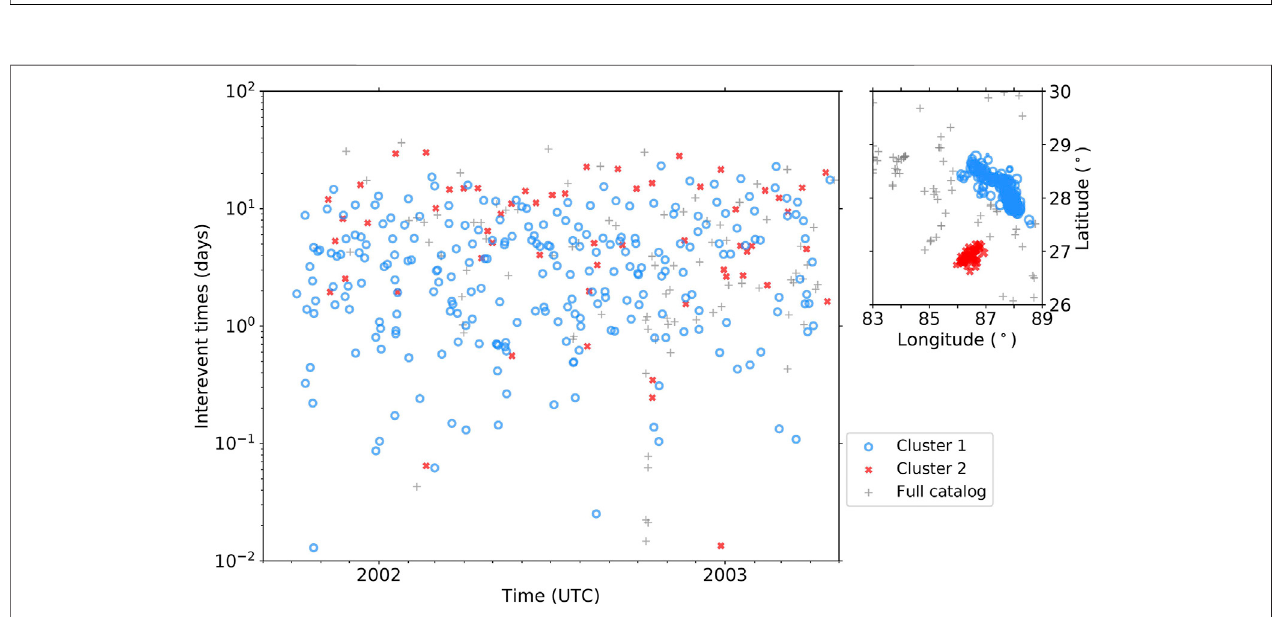
FIGURE 6 | Inter-event times for the intermediate-depth earthquakes ( > 40 km) that occurred between 2001 and 2003 for Cluster 1 (blue circle), Cluster 2 (red cross) and the rest of the events in the catalog (gray cross). Inset depicts the spatial distribution of the events.